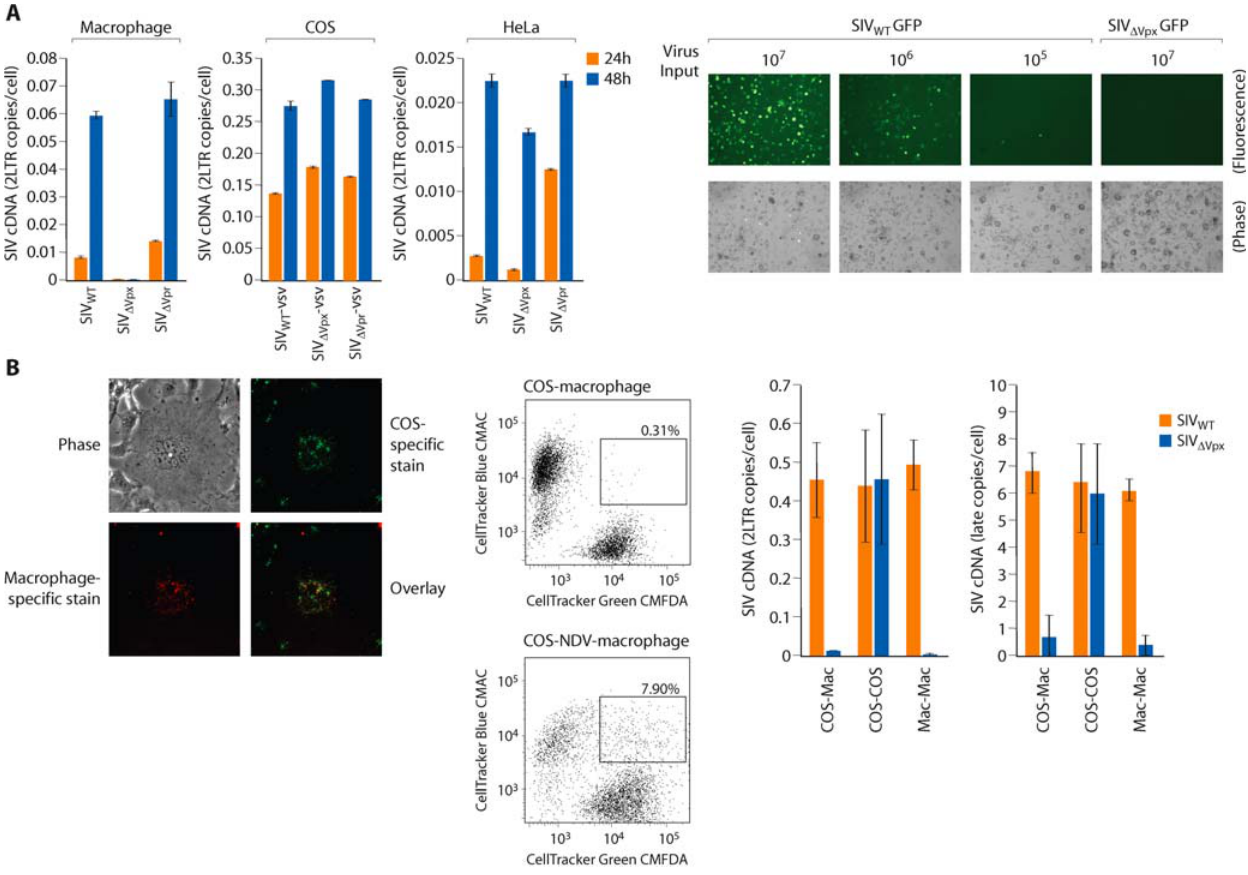
Figure 1. Vpx antagonizes an antiviral restriction in macrophages. ( A) Differential susceptibility of macrophages and cell lines to infection by wild type and Vpx-deleted ( D Vpx) or Vpr-deleted ( D Vpr) variants of SIV SM . Virus infection was gauged from the levels of viral 2-LTR cDNA at 24 and 48 h post infection. Right panels, comparison of infectivity of wild type and Vpx deleted SIV GFP variants. Macrophages were infected with 10 7 , 10 6 or 10 5 RT unites of SIV WT -GFP or 10 7 RT units of SIV D Vpx GFP. Macrophages were visualized 48 h post infection by phase and fluorescence microscopy ( B) Differential infectivity of wild type and Vpx-deleted SIV variants for macrophage-COS heterokaryons. Heterokaryons were formed between primary macrophages and between COS cells expressing fusogenic HN and F proteins of Newcastle Disease Virus. To visualize heterokaryons by fluorescence microscopy, COS cells were stained with DiO (green) and macrophages were stained with DiI (red) (magnification 6 320; left panel). FACS analysis of macrophage-COS heterokaryons (middle panel). COS cells were cotransfected with NDV HN and F expression vectors (COS-NDV) or with empty, control vectors (COS). COS cells were stained with CellTracker Green CMFDA and macrophages were stained with CellTracker Blue CMAC. Double-stained cells were sorted as indicated by the gate. Susceptibility of macrophage/COS heterokaryons and COS and macrophage homokaryons to infection by SIV WT and SIV D vpx virus variants (right panel). Infection was gauged from levels of late cDNAs and 2-LTR circle cDNAs (error bars are s.d. of 6 replicate samples from two independent